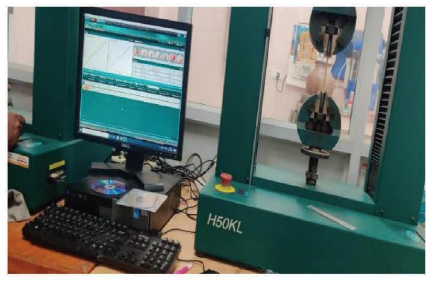
Figure 5: Tensile test.